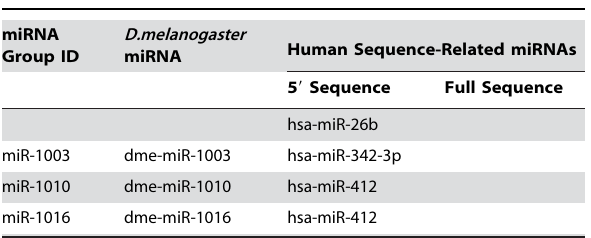
Table 5. cont. Table 5.